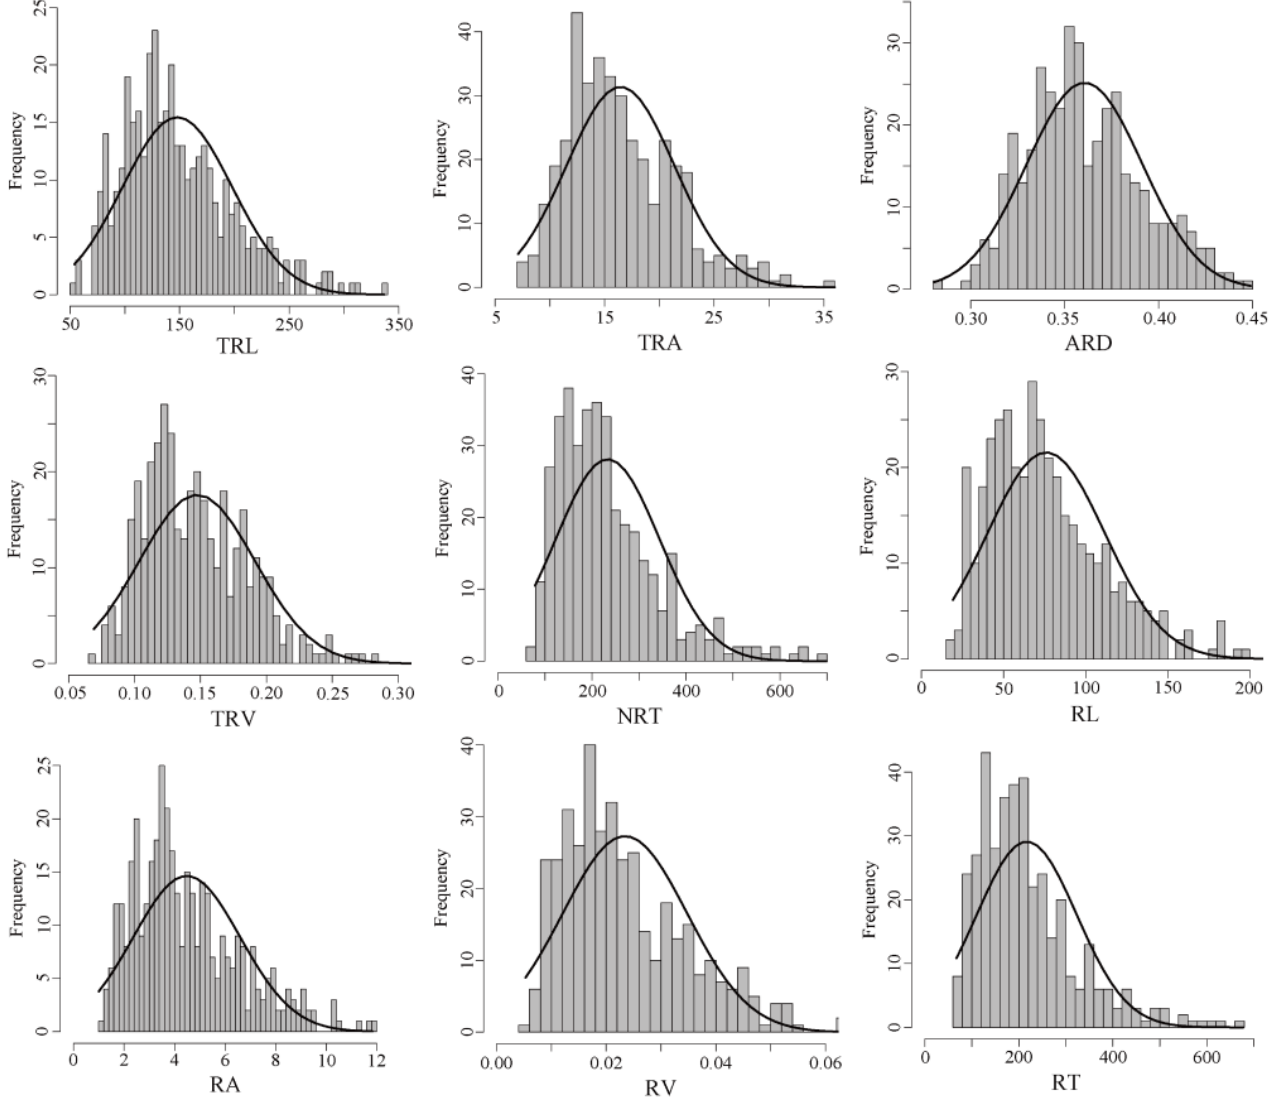
Figure 2. Distribution frequency of the RSA traits of 388 wheat accessions under OPC. The black curve represents the density curve.